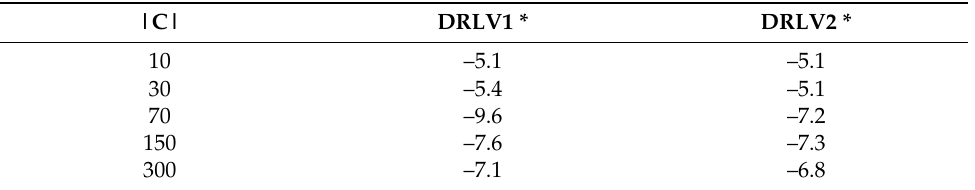
Table 2. Solution Quality. * Results presented as percentage gap when compared to DRLF. Result = 100 ∗ AVG((Algorithm – DRLF)/DRLF).